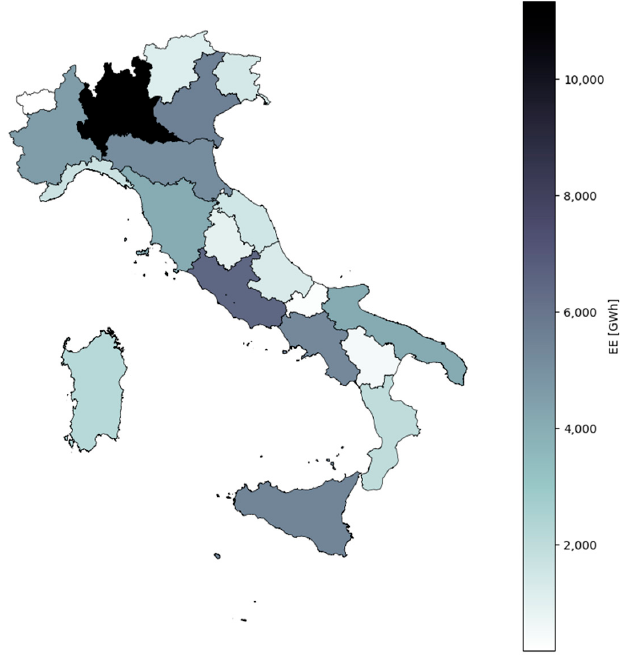
Figure 2. Electricity consumption of the residential sector in Italy in 2018 [9].